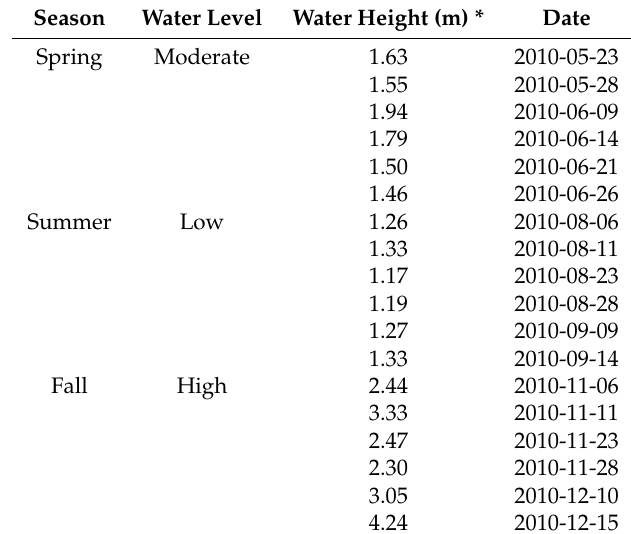
Table 3. Characteristics of the ALOS-1 PALSAR L-HH and L-HV images used in the study as a function of the season and the water levels.